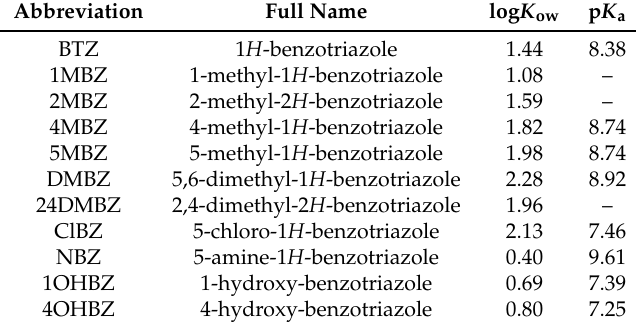
Table 1. Table of the reviewed compounds, their abbreviations and selected chemical properties (log K ow , p K a : predicted values from the Scifinder